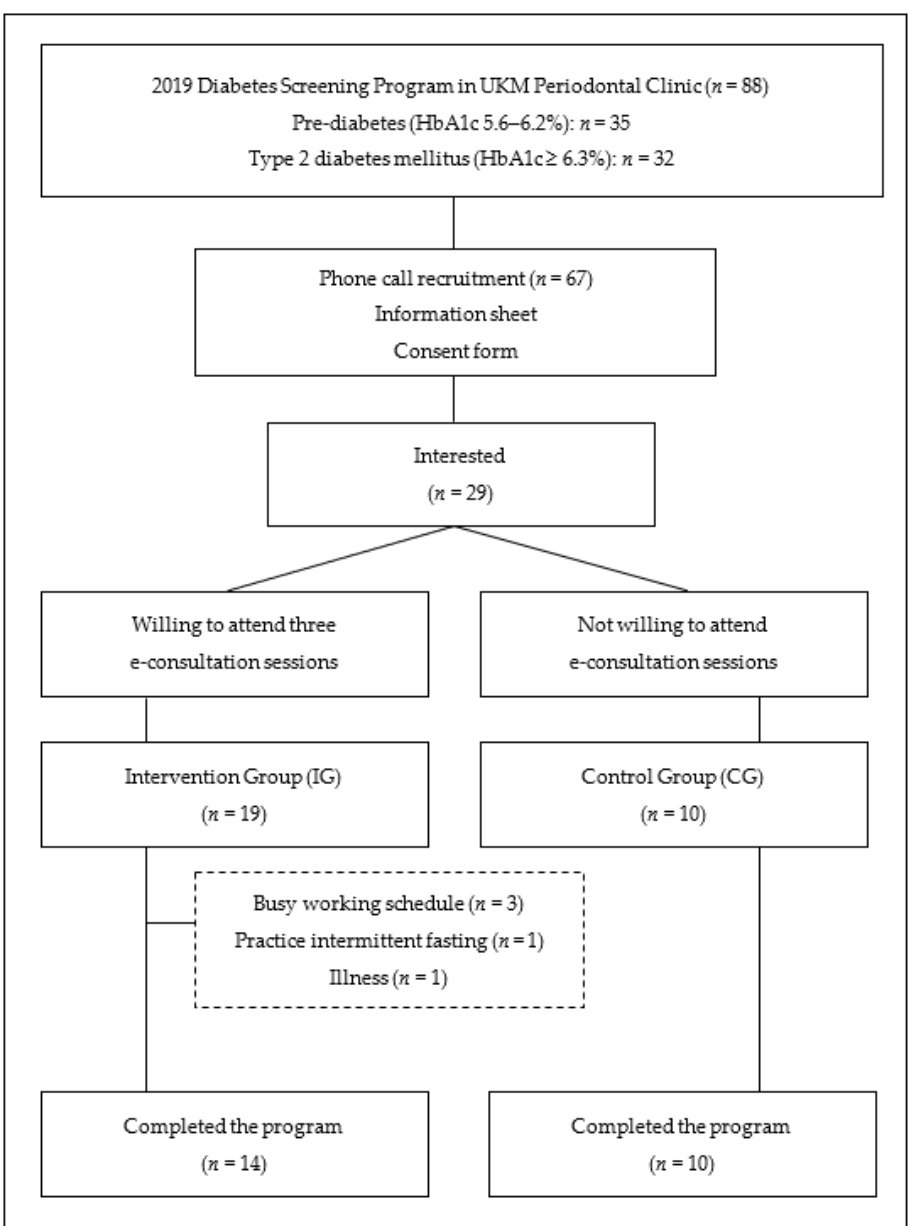
Figure 1. Participants’ enrolment.